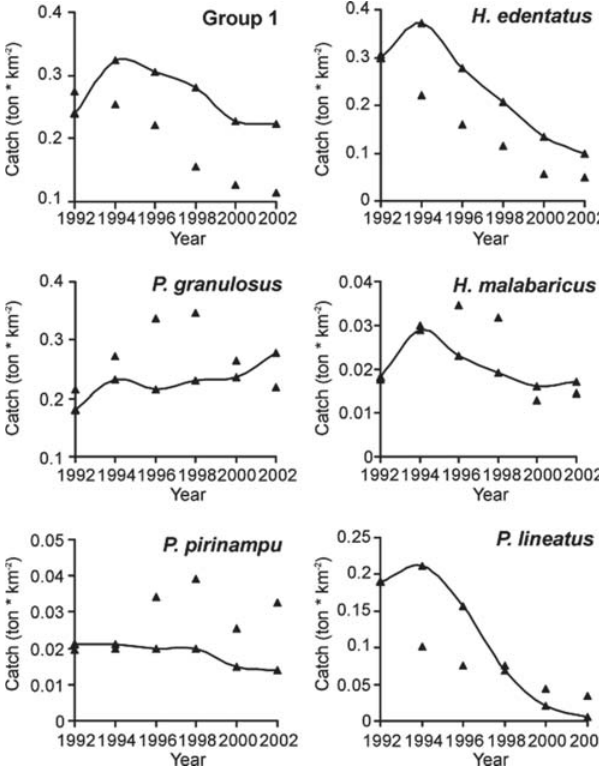
Fig. 3. Simulated catches (solid line) and catch values ob- served (triangles) for the main species of the I TAIPU -2 model, under the same fishing effort of 1998. Simulations made in Ecopath with Ecosim (Subroutine: Run Ecossim, module: Re-